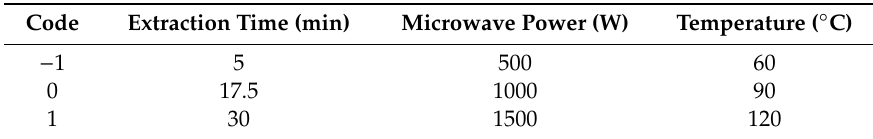
Table 1. The coded values and corresponding actual values of the optimization parameters used in the response surface analysis. Code Extraction Time (min) Microwave Power (W) Temperature ( ◦